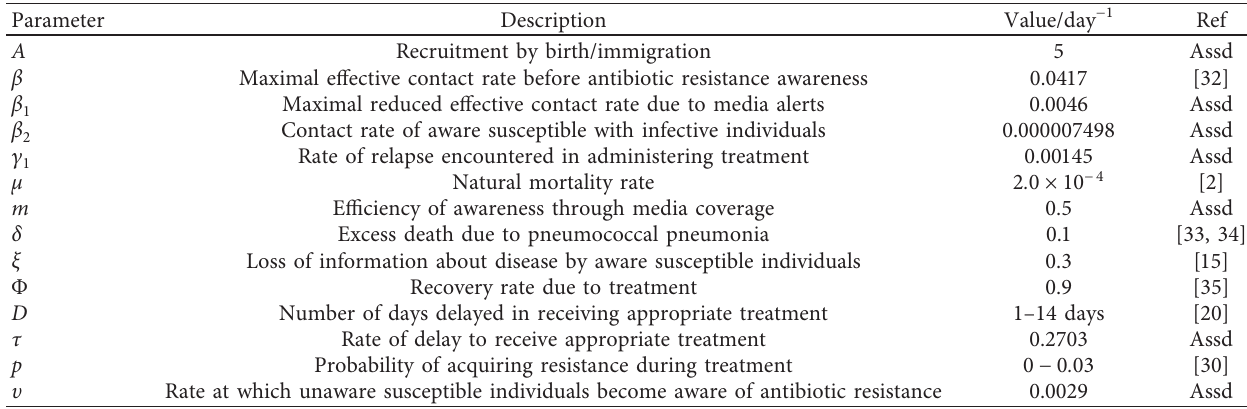
Table 1: Description of parameters.